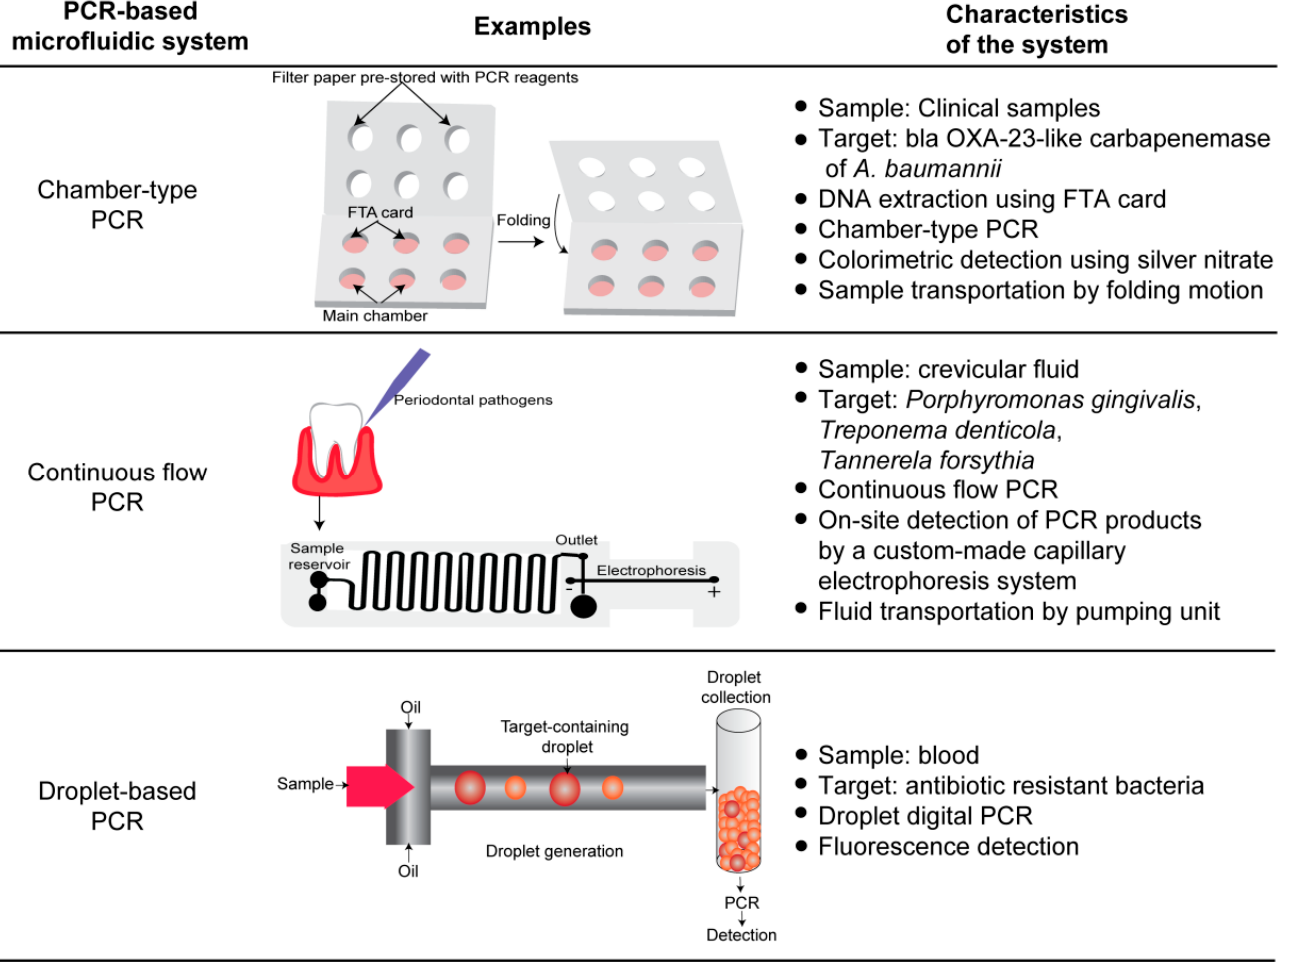
Figure 3. Examples of PCR-based microfluidic devices and systems used for pathogen detection. Reproduced from [47,51,57].